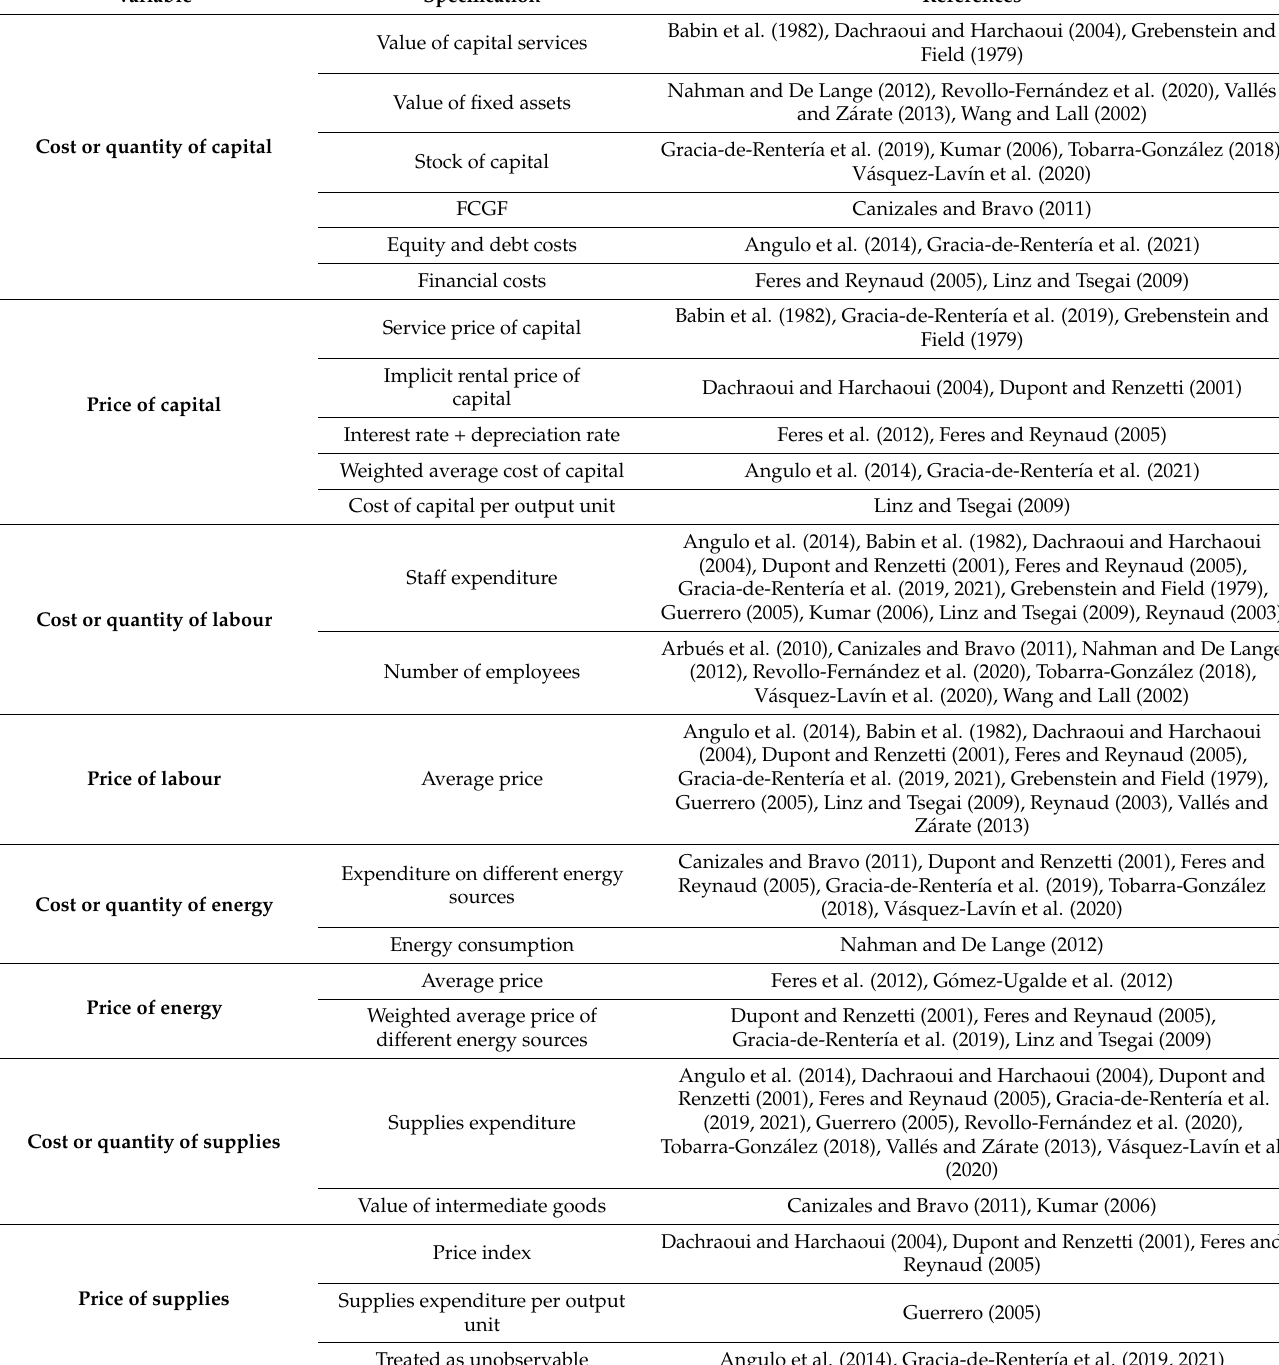
Table 2. Specification of